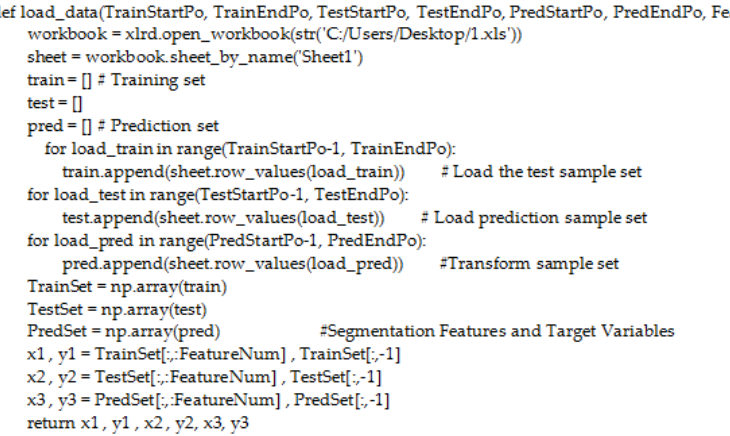
Figure 3. Random forest program diagram (random classification of sample data).